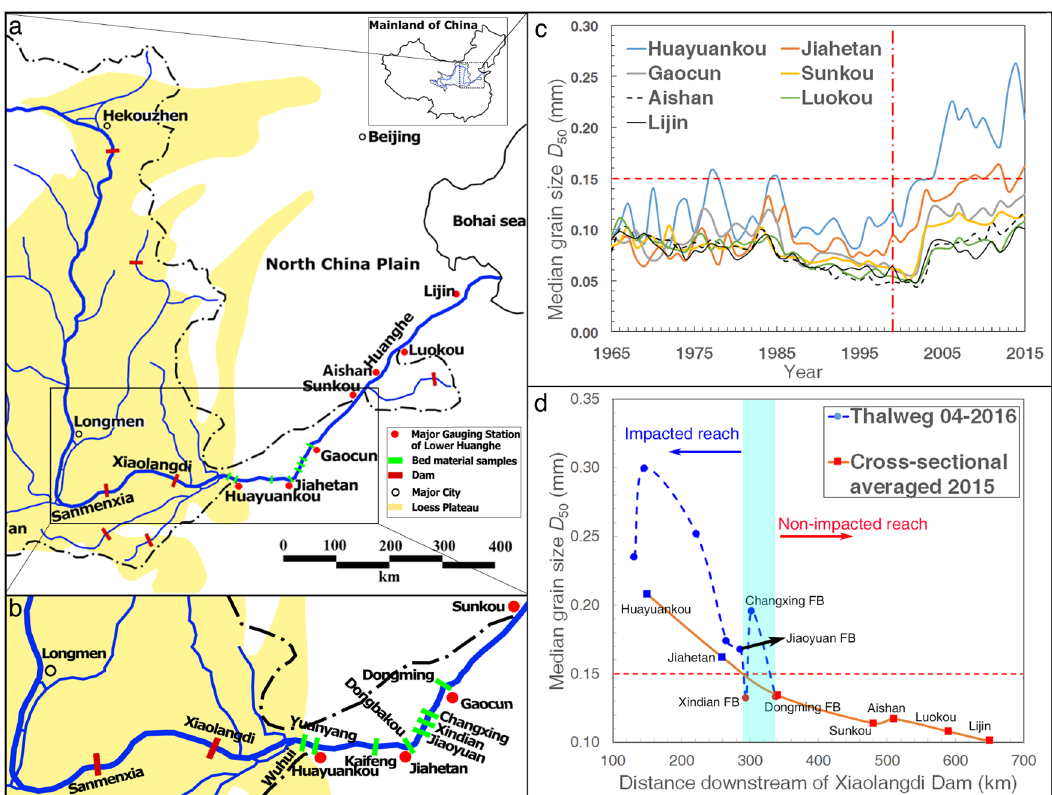
Fig. 1 Maps of the lower Yellow River (Huanghe), China, and trends in spatio-temporal evolution of bed material grain size. a Map of the lower Yellow River; b Detailed view of box shown in ( a ) illustrating locations for sampling of thalweg bed material; c Cross-sectionally averaged bed material grain size, surveyed at the seven major gauging stations, over a 50-yr period (see locations in ( a ). Vertical dot-dashed line demarcates the time when the Xiaolangdi Dam became operative. Horizontal dashed line demarcates the upper bound of bed material (0.15 mm) under pre-damming conditions; d Bed material grain size for the thalweg of the upper reach of the LYR. The transition between the non-impacted and impacted reaches of the LYR (blue shading) is located between Jiaoyuan Floating Bridge and the Gaocun gauge station; red markers indicate where median grain-size drops below 0.15